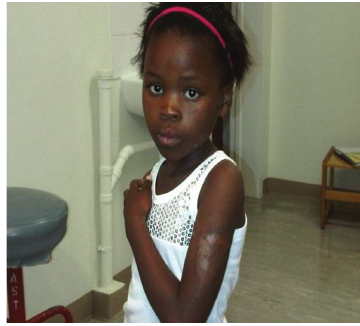
Figure 1: The subject demonstrating a lightning burn to her left arm.